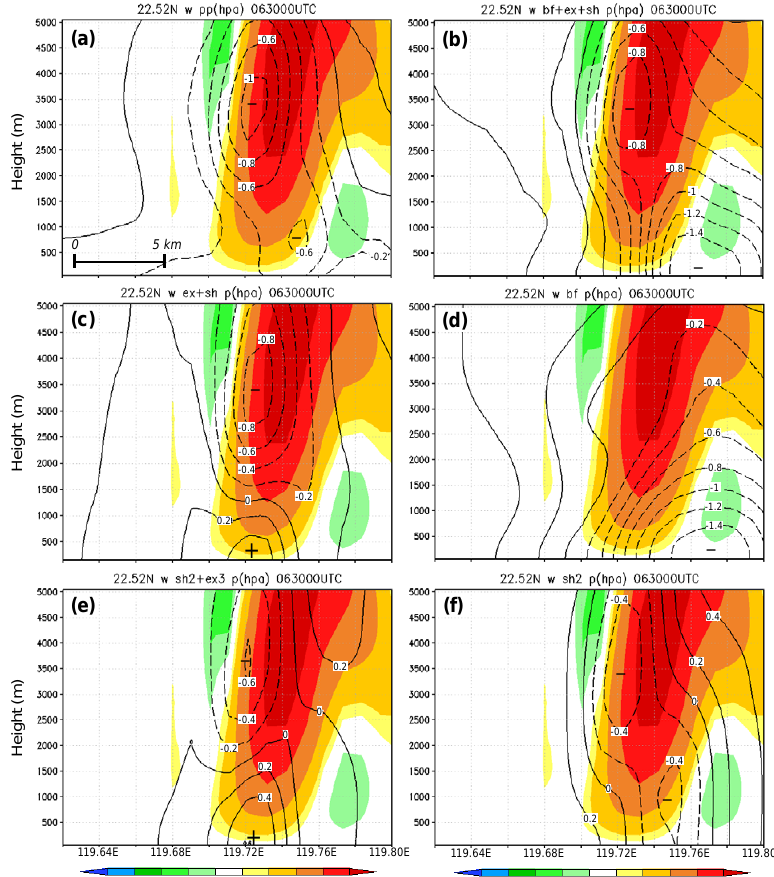
Figure 15. As in Fig. 14, except for w (ms − 1 , color, scale at bottom) and (a) total p (cid:48) (hPa, contours, every 0.2hPa, dashed for negative values) separated from the background, and (b) p (cid:48) from SH2 alone (all in hPa, contours) in Eq. (13) solved by the relaxation method. The positive and negative centers are labeled by plus and minus signs,